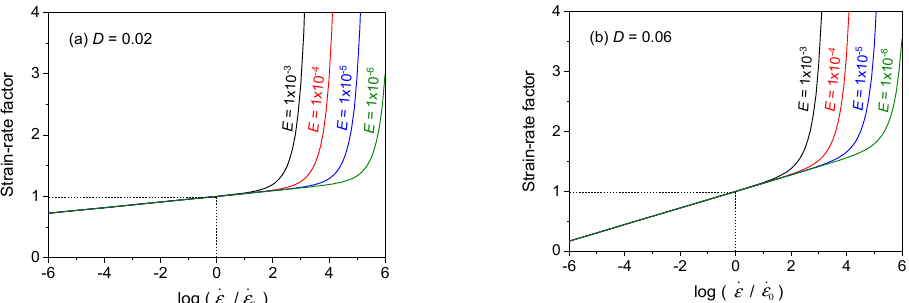
. . ε / ε 0 ) for different E values when